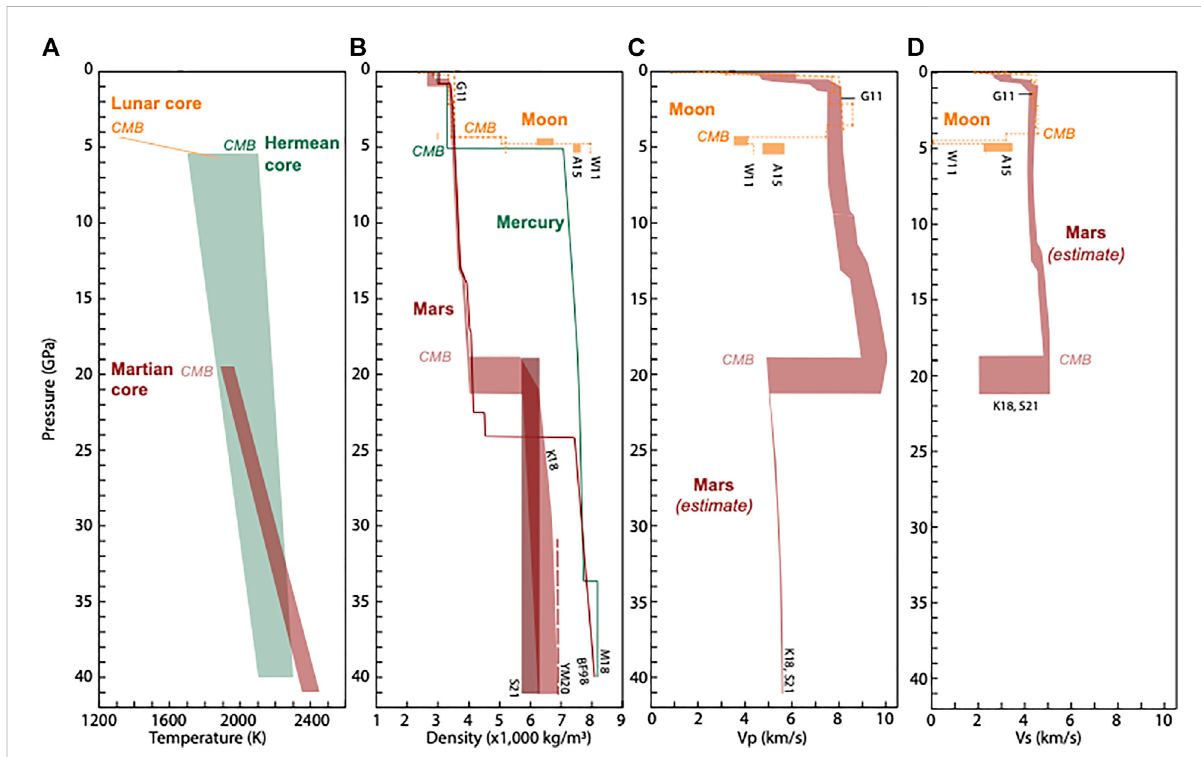
FIGURE 2 Temperature (A) , density (B) , Vp (C) and Vs (D) pro fi les across Mars, the Moon, and Mercury. Density pro fi les are from Khan et al., 2018 (K18), Bertka and Fei, 1998 (BF98) (Mars); Weber et al., 2011 (W11; light blue dashed lines), Garcia et al., 2011 (G11; dark blue dashed lines), and Antonangeli et al., 2015 (A15; light blue rectangles) (Moon), and Margot et al., 2018 (Mercury). Mars mean core density from Yoshizaki and McDonough, 2020 (YM20) and Stähler et al., 2021 (S21) is also shown. Seismic velocities are from Stähler et al., 2021, Khan et al., 2018 (Mars), Weber et al., 2011, Garcia et al., 2011, and Antonangeli et al., 2015 (Moon). For each terrestrial body, CMB refers to core-mantle